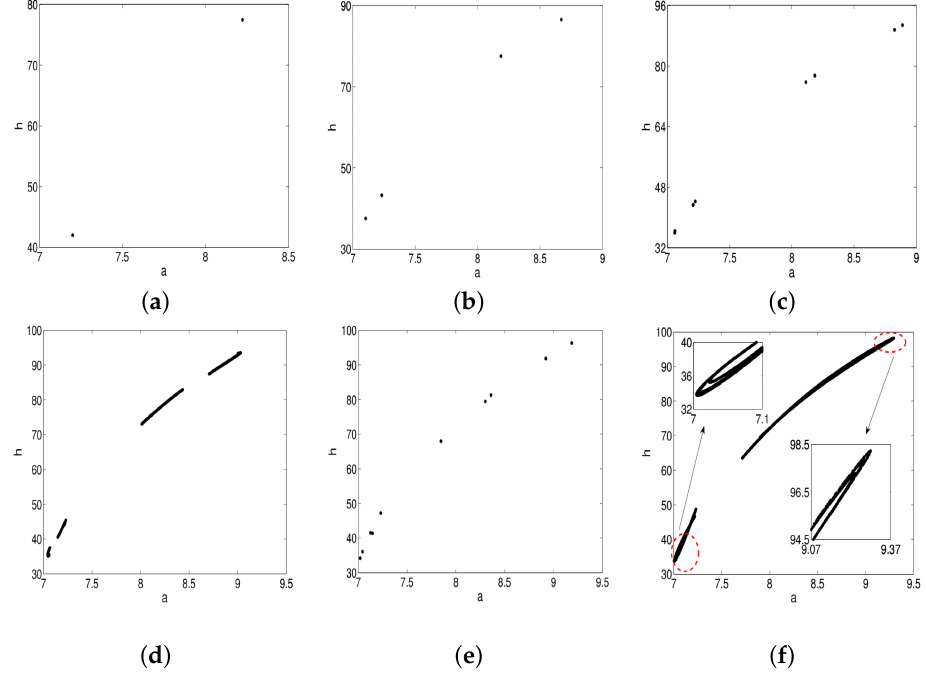
Figure 3. Phase portraits for different values of τ corresponding to Figure 1a. ( a ) τ = 3.6; ( b ) τ = 3.8;